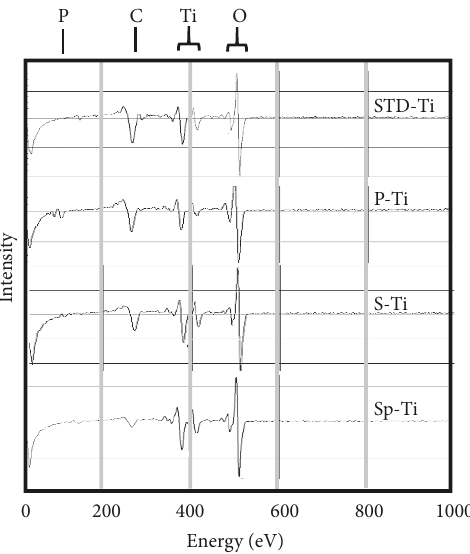
Figure 3: EDS results on the surface of the Ti plates after immersion in SBF for 1 day.